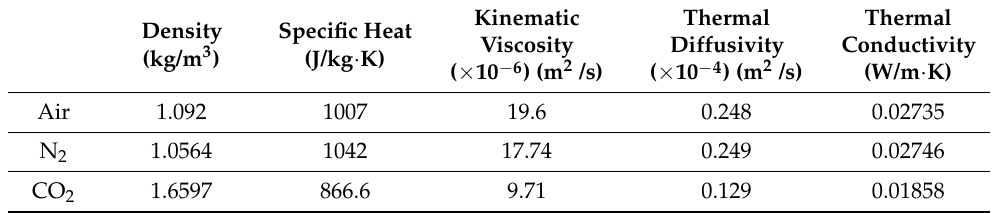
Table 1. Gas medium properties at 50 ◦ C (adapted from